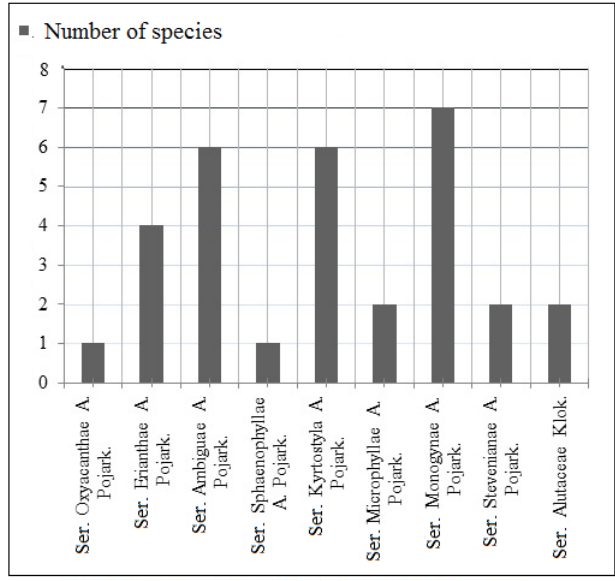
Fig. 1. Distribution of the Crataegus L. species of